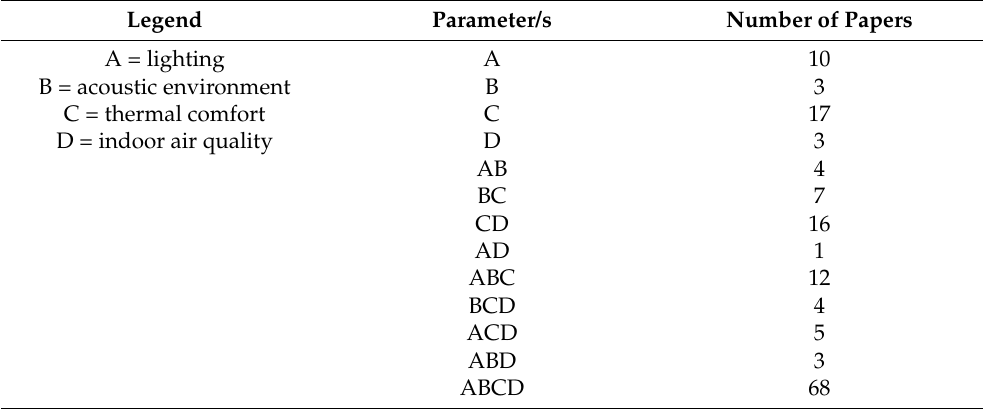
Table 6. Number of studies per